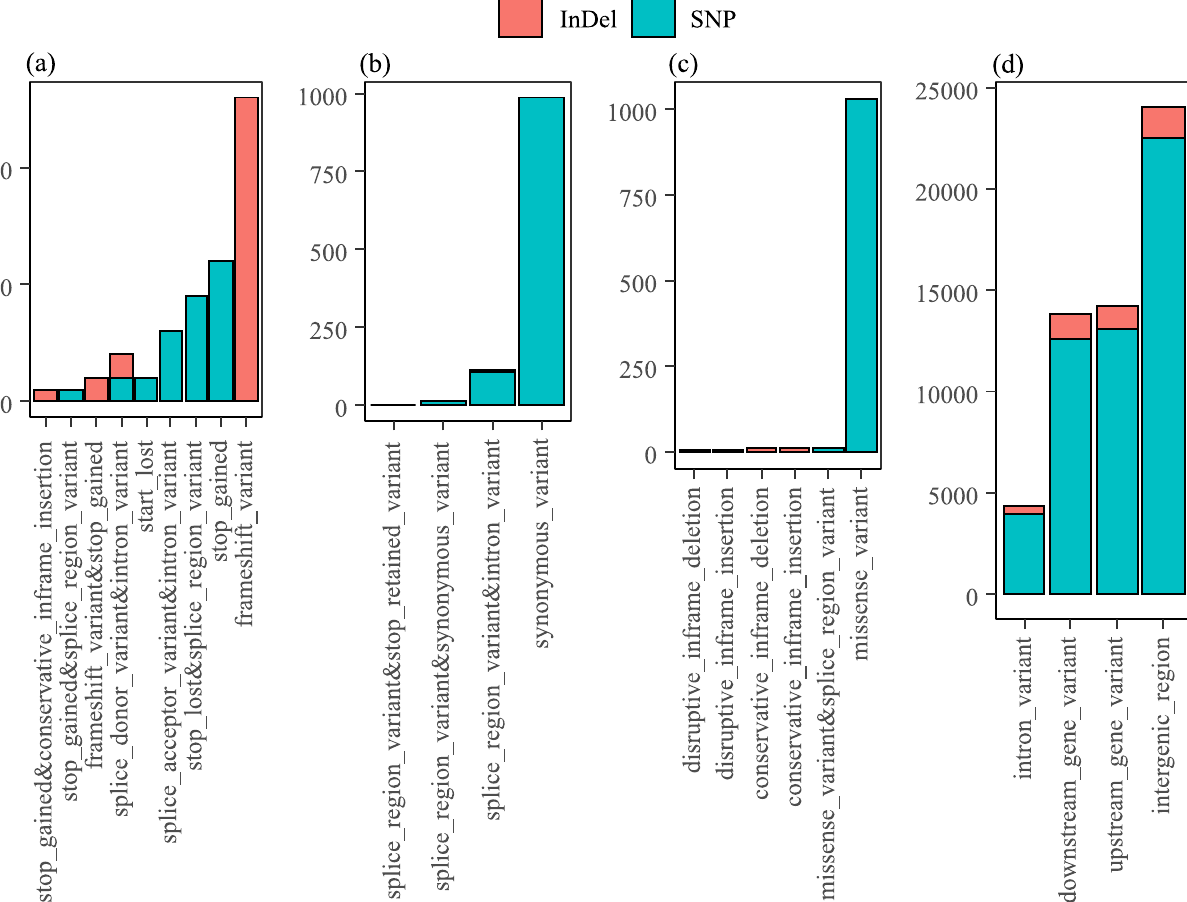
Figure 3. Distribution of SNP and InDel effects in the sub-classification of ( a ) high, ( b ) moderate, ( c ) low, and ( d ) modifier